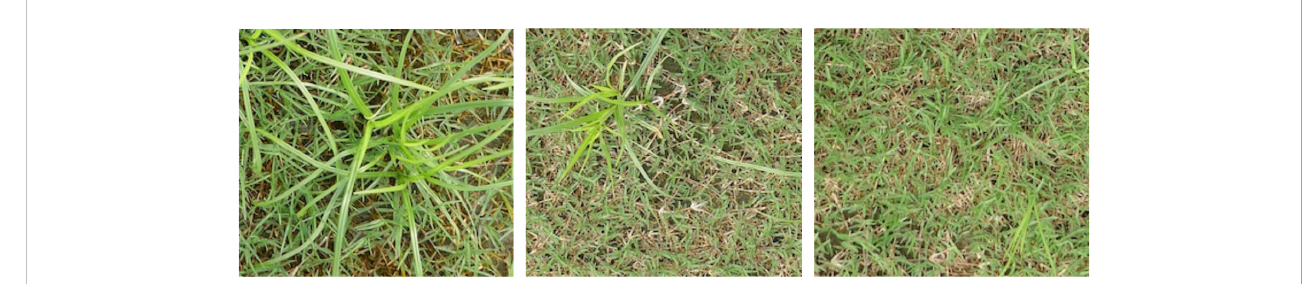
FIGURE 3 The training and testing sub-images of purple nutsedge at different growth stages and